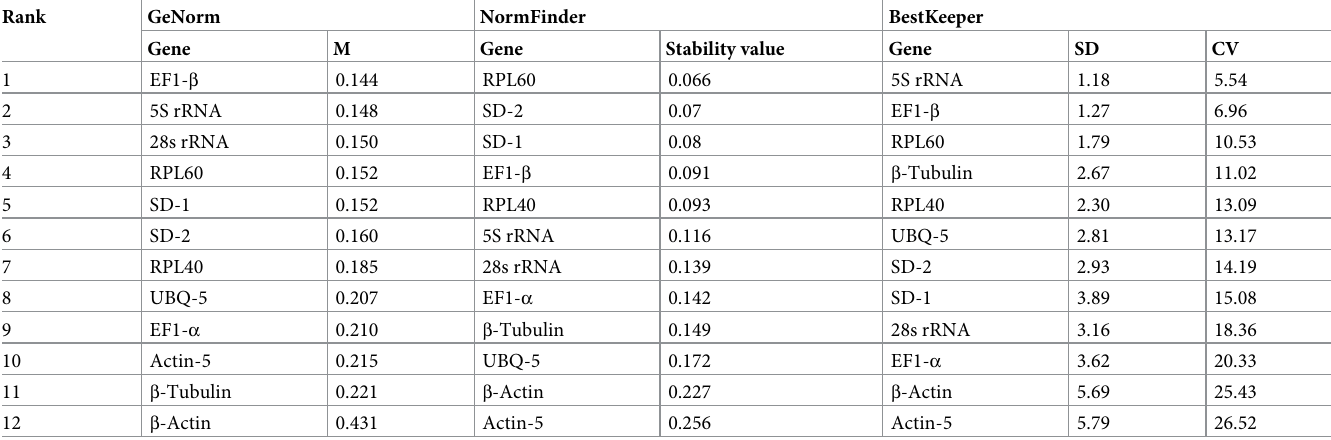
Table 3. Expression stability of 12 candidate reference genes analyzed by GeNorm, NormFinder and